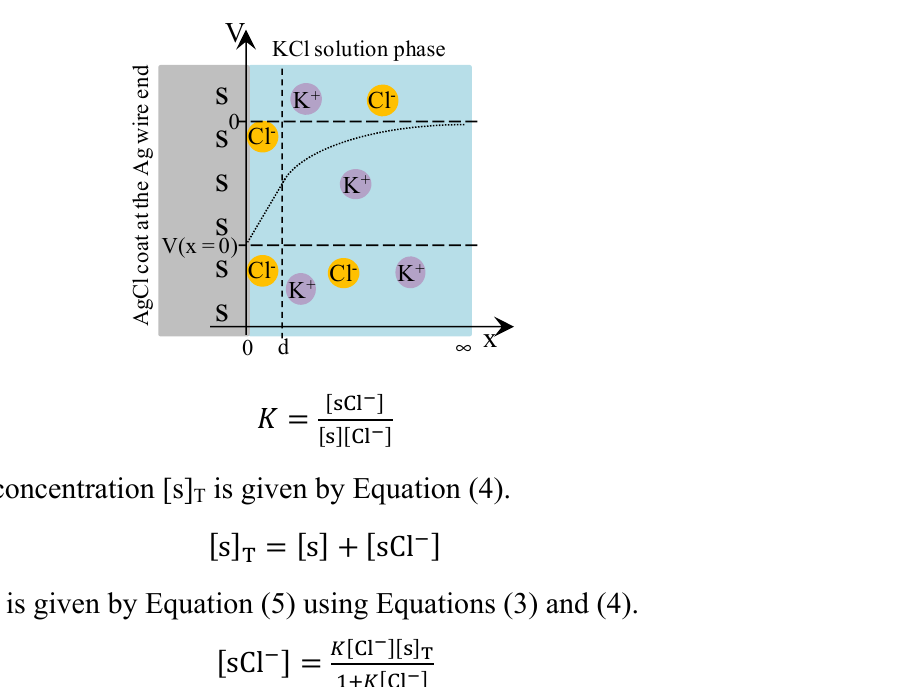
Figure 4. The interface between AgCl coat at the Ag wire end and KCl solution. s represents the adsorption site on the AgCl surface. Some chloride ions are in the adsorbed state on the AgCl surface. Coordinate system is set as illustrated, where x = 0 represents the interface plane between the AgCl surface and KCl solution phase and x = d represents the plane of ion diffuse phase closest to the adsorption site of AgCl. V represents the potential, where V = 0 at x = ∞ . Dotted line represents the potential behavior